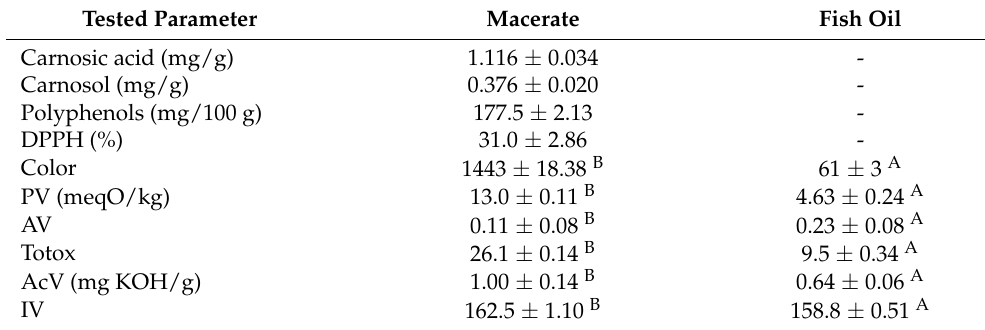
Table 2. Parameters of the sage macerate and fish oil used to obtain the macerate.